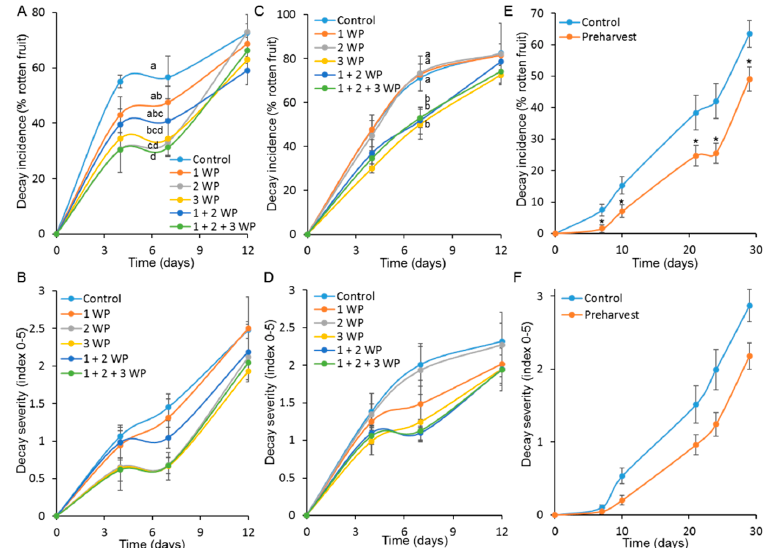
Figure 4. Effect of preharvest application of phenylalanine on postharvest decay in strawberry and mandarin. “Malach” or “Gilli” strawberry plants were sprayed preharvest with water or 6 mM phenylalanine 1, 2, or 3 weeks preharvest (WP) (or their combination). After harvest, the fruits were stored at 10 °C for 12 days. ( A ) Decay incidence (percentage of rotten fruit) and ( B ) decay severity (index, 0–5) in strawberries cv. Gilli. ( C ) Decay incidence and ( D ) decay severity in strawberries cv. Malach. ( E , F ) “Michal” mandarin orchard was sprayed with water or 6 mM phenylalanine 3 days before harvest. ( E ) Decay incidence and ( F ) decay severity in harvested fruit. Values are mean ± SE. Different letters indicate a significant difference ( p ≤ 0.05) according to t-tests or one-way ANOVA.